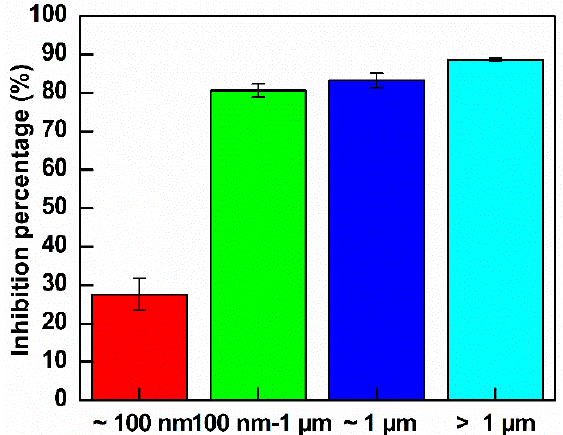
Figure 12. Inhibition rates of the control E. coli and treated E. coli with GO–Ag NPs with different GO sizes after 4 h of observation ( n = 3).